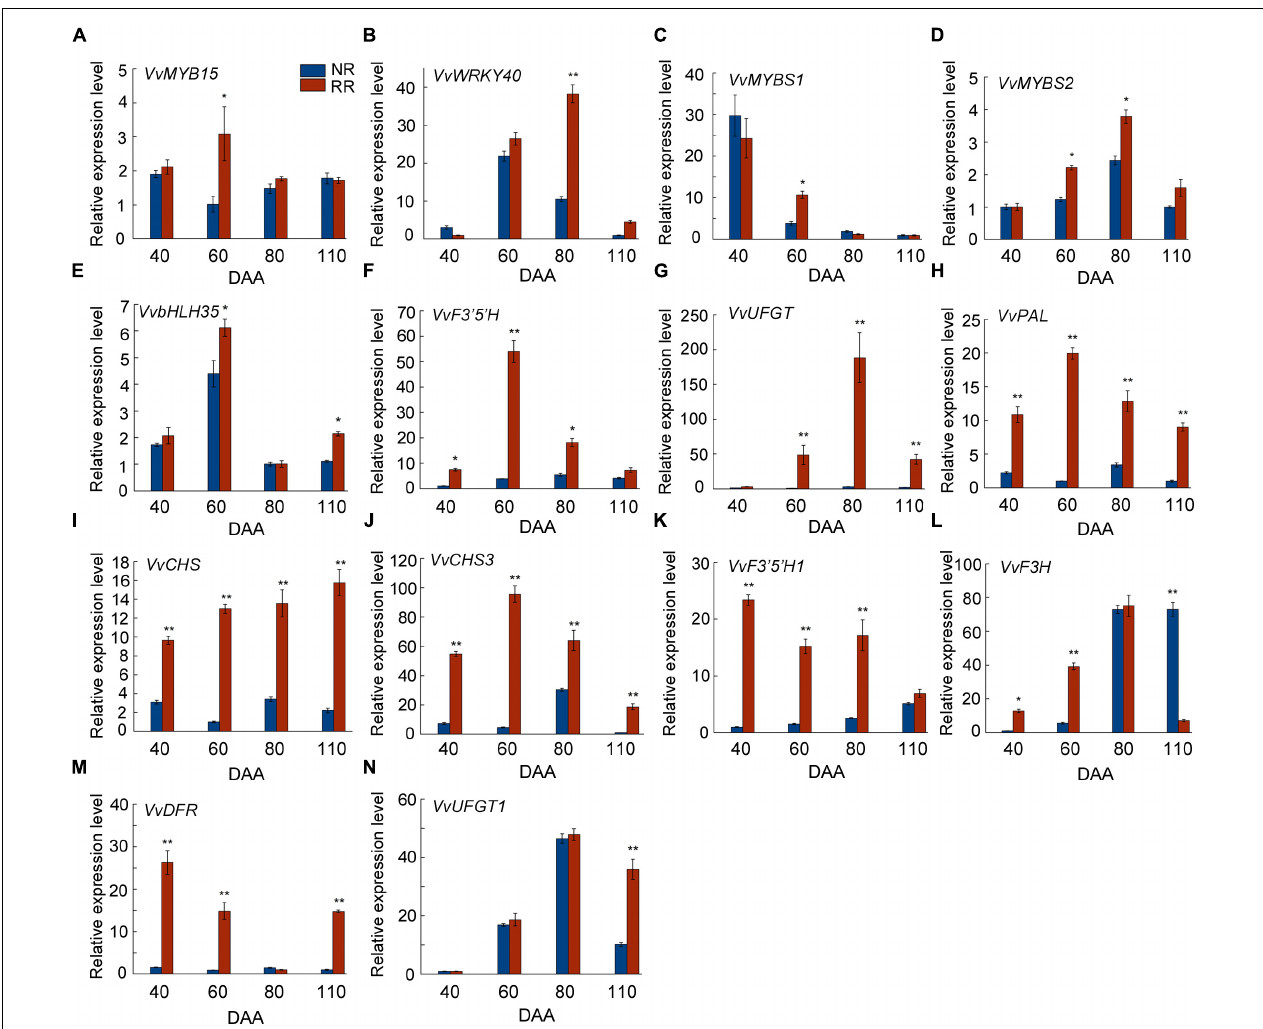
FIGURE 2 | Analysis of expression level of genes related to anthocyanin biosynthesis under root restriction (RR) and no root restriction (NR), (A) VvMYB15 , (B) VvWRKY40 , (C) VvMYBS1 , (D) VvMYBS2 , (E) VvbHLH35 , (F) VvF3 (cid:48) 5 (cid:48) H , (G) VvUFGT , (H) VvPAL , (I) VvCHS , (J) VvCHS3 , (K) VvF3 (cid:48) 5 (cid:48) H 1 , (L) VvF3H , (M) VvDFR , and (N) VvUFGT1 . Asterisks represent different level of significance ( P ≤ 0.05*, P ≤ 0.01**), and significant differences are indicted by different lowercase letters based on independent sample t -test.